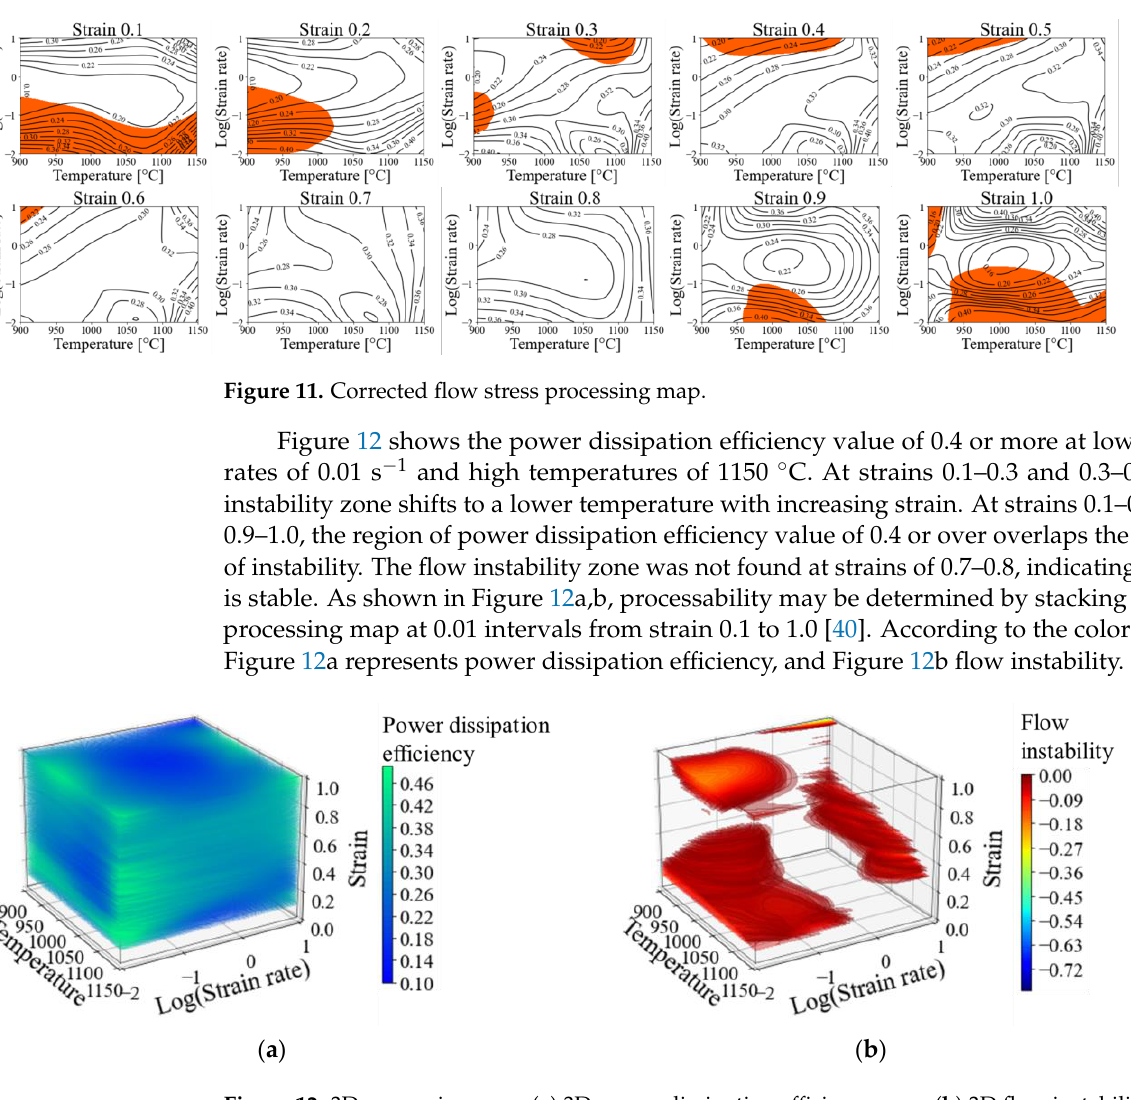
Figure 10. Experimental flow stress processing map.